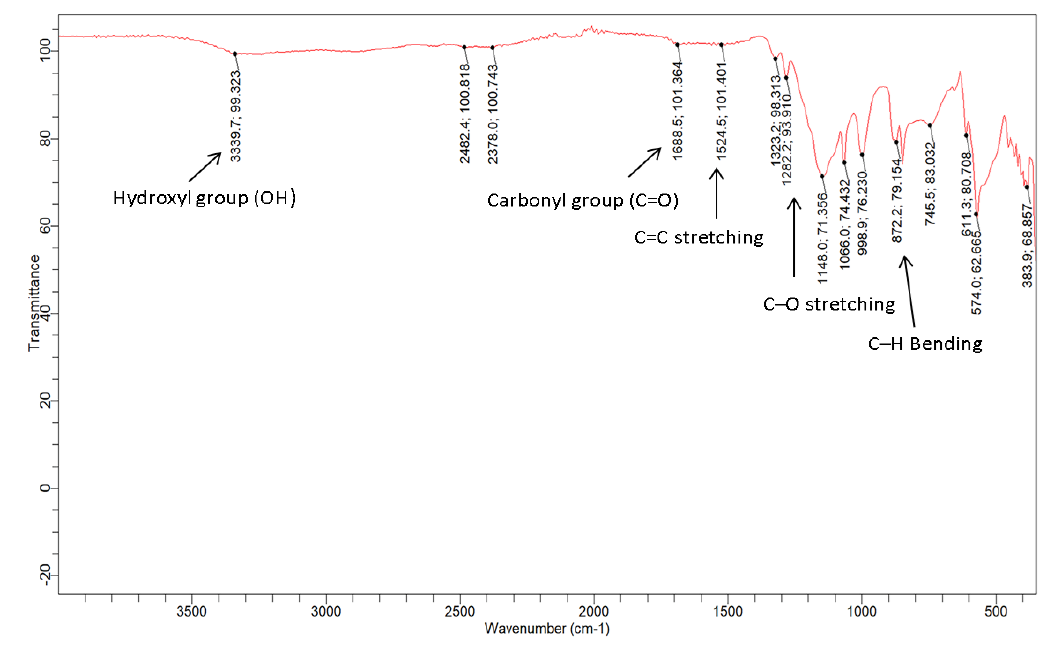
Figure 5. IR-spectra for GO-date seeds.